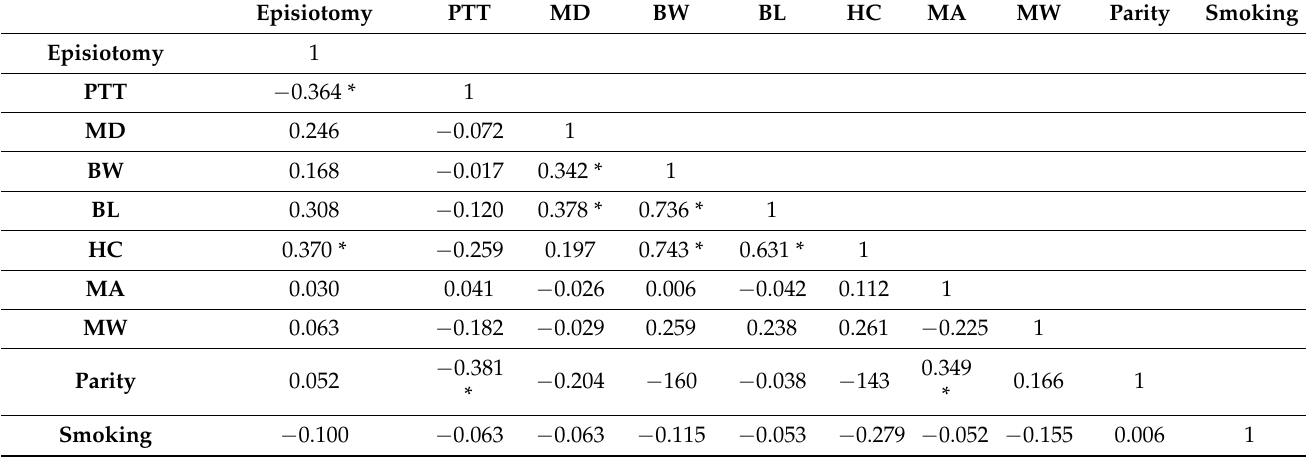
of perineal tears. Similarly, the mode of delivery was positively associated with birth weight ( r = 0.342; p = 0.020) and length ( r = 0.378; p = 0.023). Head circumference was positively associated with birth weight ( r = 0.743; p < 0.001) and length ( r = 0.631; p < 0.001). Birth weight was positively associated with birth length ( r = 0.736; p < 0.001). Finally, parity was negatively correlated with type of perineal tear ( r = − 0.381; p = 0.008) and positively correlated with maternal age ( r = 0.349; p = 0.018). Table 2. Correlation matrix in the IG between maternal, childbirth, and newborn variables. Episiotomy